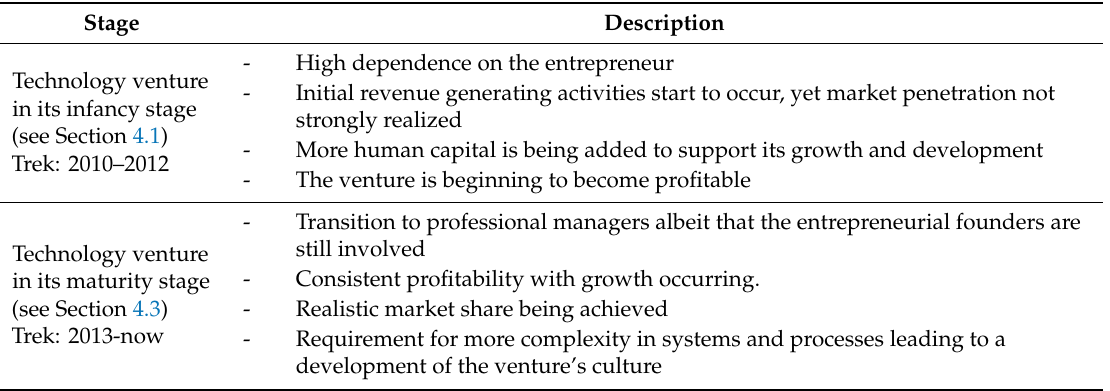
Table 1. Characteristics of main stages of technology ventures examined in this study (adapted from Cardon et al.